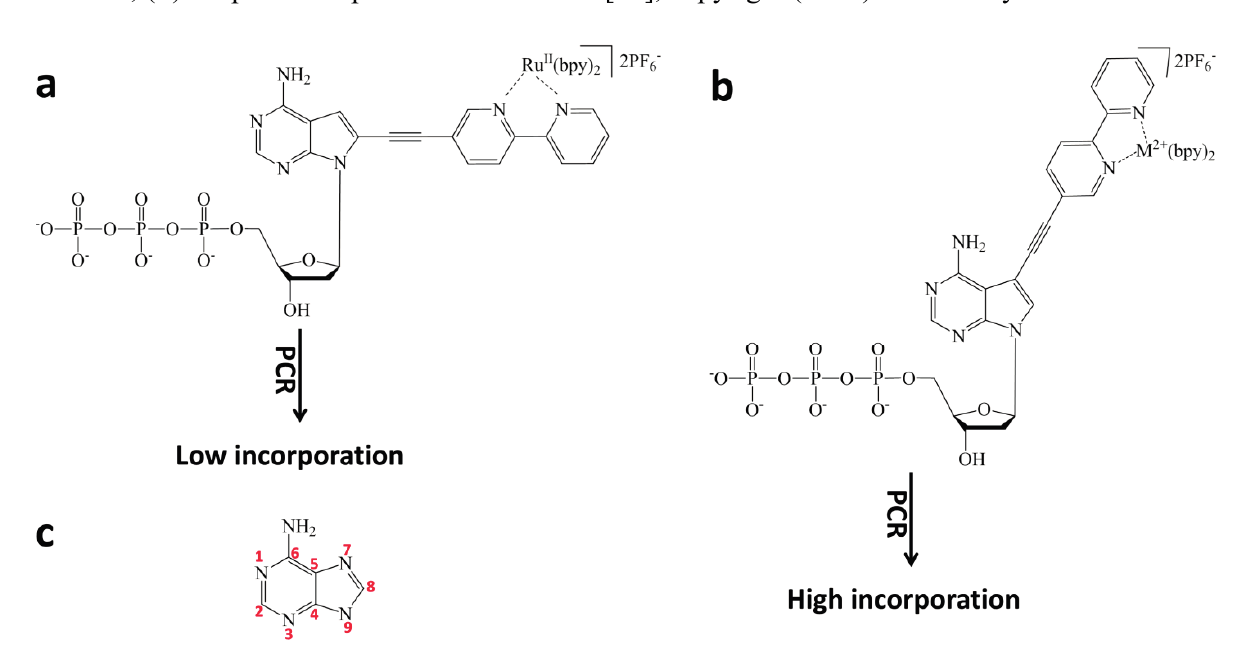
Figure 5. Incorporation of redox active metal complexes into purine bases for PCR. ( a ) incorporation in C-8 position; ( b ) incorporation in N-7 position; ( c ) the numbering of adenine. ( a ) adapted with permission from ref. [60], copyright (2007) John Wiley and Sons; ( b ) adapted with permission from ref. [63], copyright (2009) John Wiley and